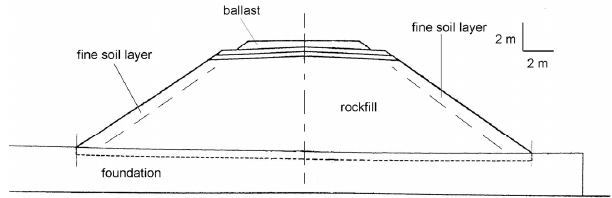
Figure 6 – Schematic cross-section of the Acquaviva embankment 8 Fig. 6. Schematic cross-section of the Acquaviva embankment.